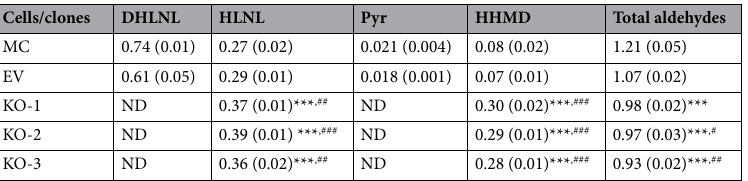
Table 7. Levels of immature reducible cross-links (DHLNL and HLNL) and mature non-reducible cross-links (Pry and HHMD) from MC, EV, and KO clones. Total aldehydes = DHLNL + HLNL + 2 × Pyr + 2 × HHMD. Values represent mean moles/mole collagen ± S.D. (n = 3) of triplicate analysis of the hydrolysates. Statistical differences were determined by Kruskal–Wallis one-way analysis of variance and means comparison with the controls by Dunnett’s method. DHLNL dihydroxylysinonorleucine, HLNL hydroxylysinonorleucine, HHMD histidinohydroxymerodesmosine, Pyr pyridinoline, MC MC3T3-E1, EV empty vector, KO knock-out. *** p < 0.001 between MC and KO; # p < 0.05, ## p < 0.01, and ### p < 0.001 between EV and KO, respectively.